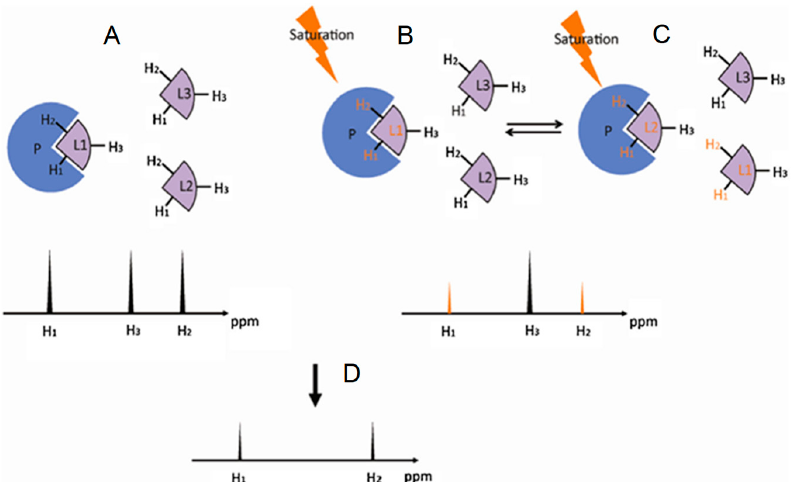
Figure 4. Schematic representation of the saturation transfer difference (STD) experiment. ( A ) The atoms of the ligand free in solution, in this case H 1 , H 2 and H 3 , generate NMR signals whose intensities are proportional to their abundance; ( B ) Upon interaction, the saturated energy-excitement (orange arrow) on the protein will be transferred to the bound atoms (orange fonts); ( C ) The on-off behavior of the protein-ligand complex in solution leads to free but magnetized ligands. The intensities of the NMR signals will reflect the difference between the non-saturated (black peak) and the saturated atoms (orange peaks); The resultant STD spectrum ( D ) will be generated by subtracting the saturated spectrum ( B , C ) from the reference spectrum ( A ). Modified with permission from Springer Anal. Bioanal. Chem. License in conditions provided by Springer Nature and Copyright Clearance Center, Inc. [25].